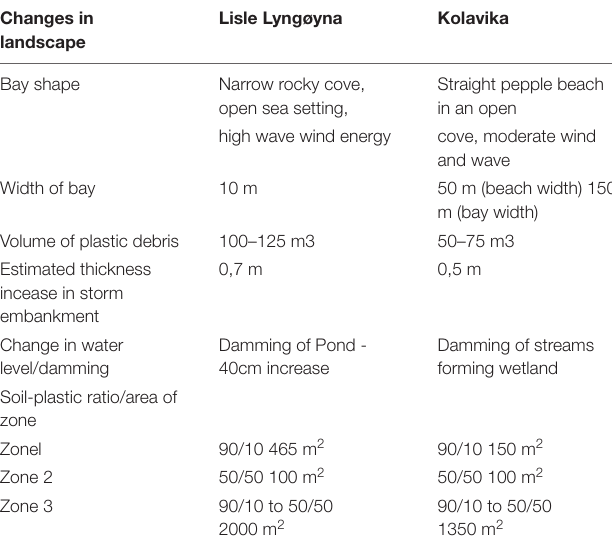
TABLE 3 | Quantification of landscape changes at the two case studies. Changes in